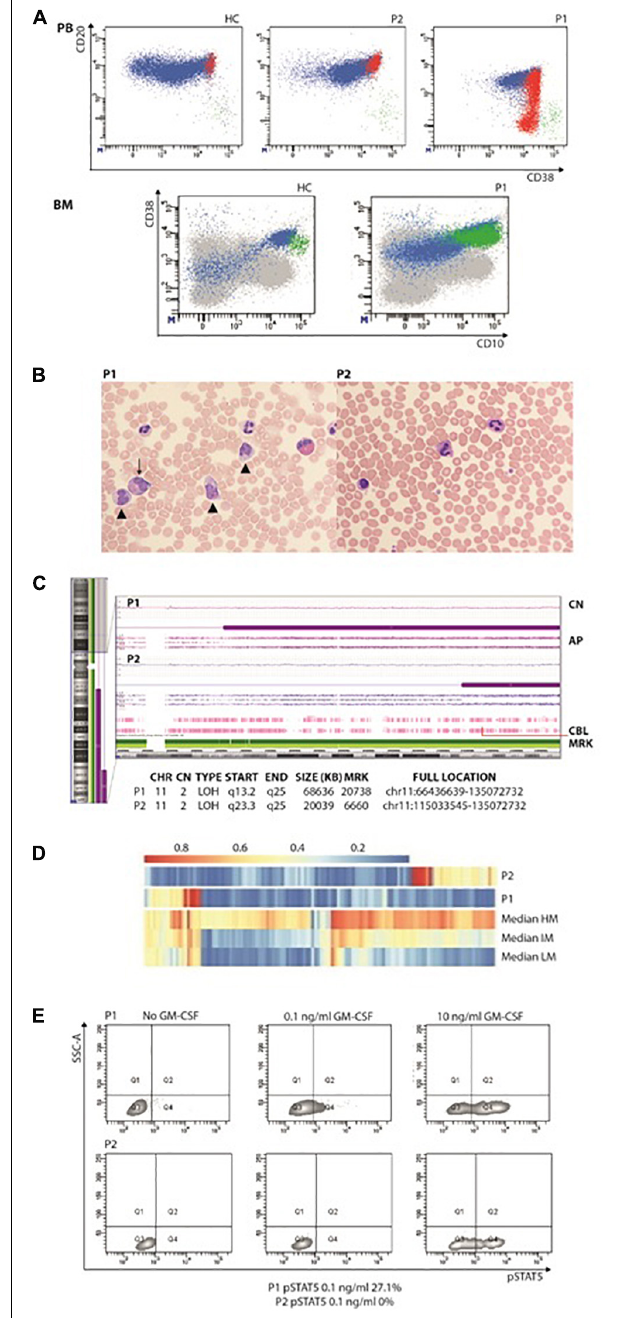
FIGURE 1 | (A) Increased immature/transitional B in the peripheral blood (upper panel; in red are represented CD10 + CD21 − CD27 − transitional or immature B cells, in green CD10 − CD21 − CD27 + terminally differentiated B cells) and bone marrow (lower panel; in green CD34 + CD38 + CD10 + ). (B) Peripheral blood smears showing JMML in P1 (left panel): leukocytosis with monocytosis (triangle) and myeloid precursors (arrows). In the right panel, anisocytosis of platelets without leukocytosis or monocytosis in P2’s peripheral blood smear. (C) CytoScan HD Array (SNP) analysis: allelic peak (AP) graph showing large copy neutral (CN = 2) loss of heterozygosity (LOH) regions in long arm of chromosome 11, in both patients; common LOH